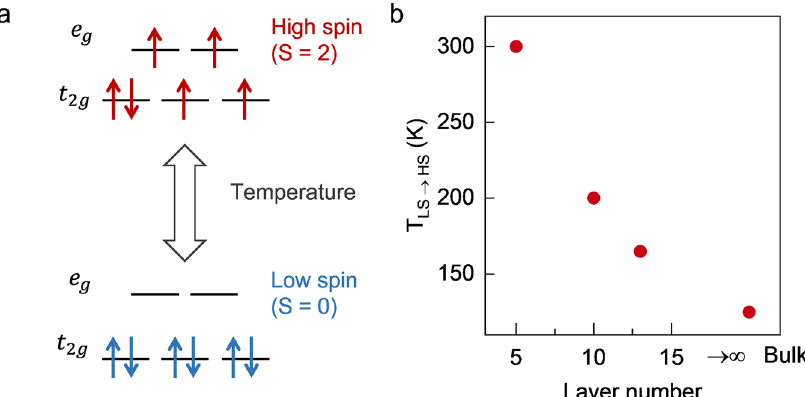
Fig. 4 Thickness-dependent spin-crossover transition temperature in exfoliated FTBQS samples. a Schematic illustration of the spin con fi guration of the Fe(II) ion for the high spin (HS) and low spin (LS) states. b The layer dependence of the measured LS → HS transition temperature from Fig. 3. The transition temperature is extracted as the abrupt changes in re fl ection contrast, as the grayed out area in Fig. 3 e – h.